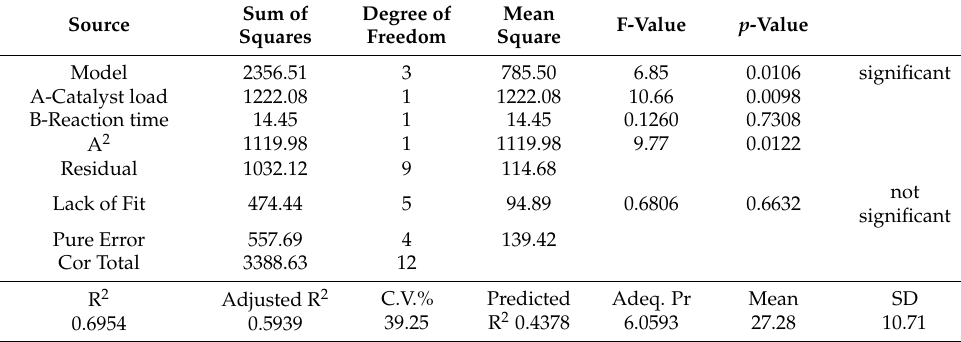
Table 7. ANOVA for quadratic model.